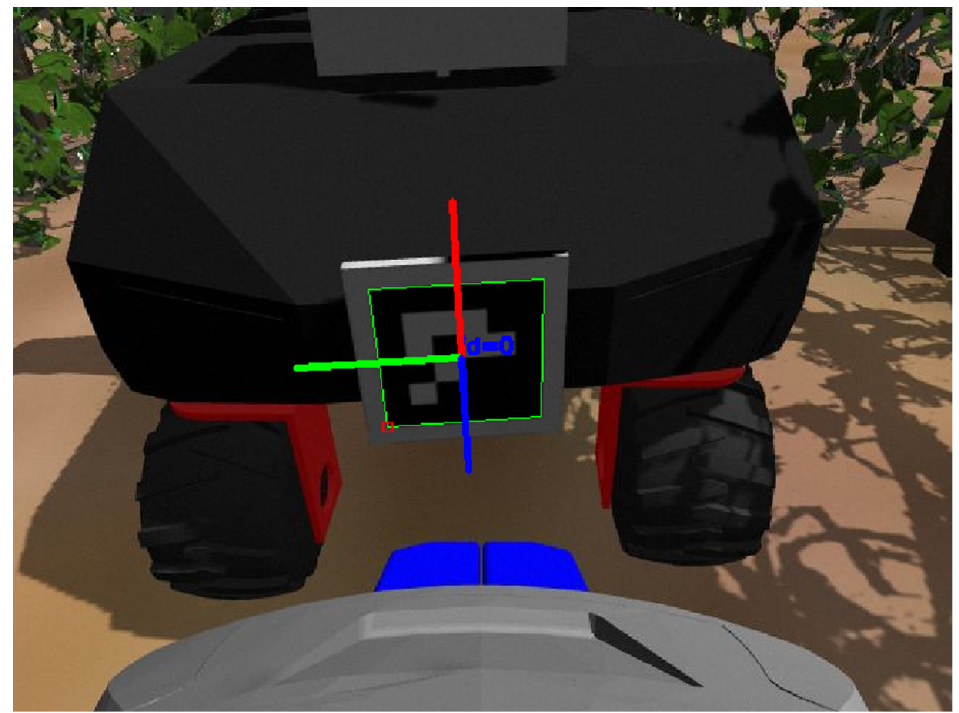
Figure 8. Fine-tuning the positioning of the helper robot behind the expert robot for task initiation using the ArUco marker. View from the helper robot’s camera.